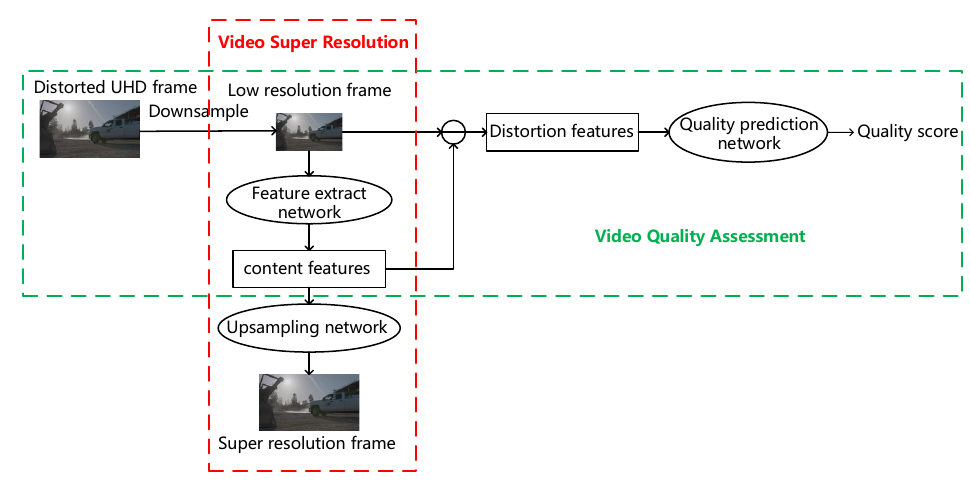
Figure 1. The relationship between video super-resolution and quality assessment. The red box shows the super-resolution process and the green box represents the structure of our method.